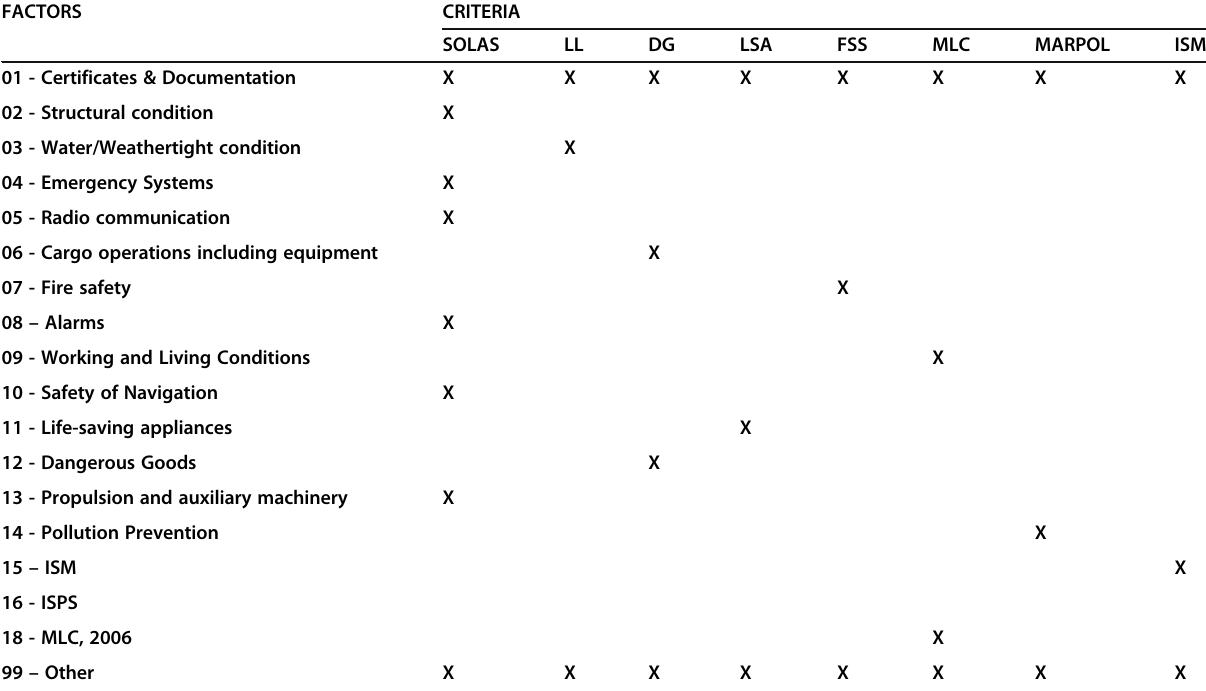
Table 2 Relevance matrix for Paris MOU deficiency codes with International Maritime regulations